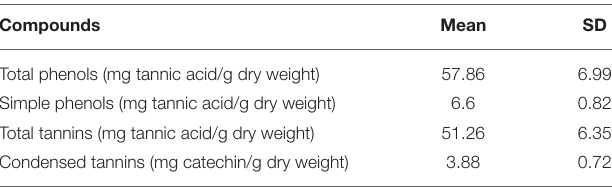
TABLE 1 | Characterization of phenolic compounds contained in the STODI ® mixture.